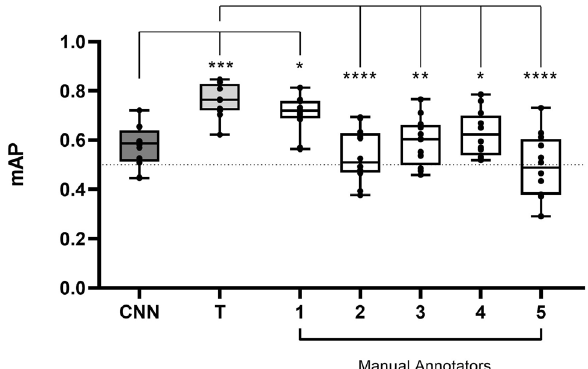
Figure 2. The CNN removes large variation between manual annotators. Six independent annotators, including manual annotators (1–5) and a network trainer (T), manually outlined the perimeter of platelets in 12 images. The mAP of the CNN was compared to all manual annotators. The mAP of the trainer was compared to manual annotators 1–5. The mean ± SD of the 12 images was plotted and analysed using one-way ANOVA with Bonferroni post-test. *p ≤ 0.05, **p ≤ 0.01, ***p ≤ 0.001, ****p ≤